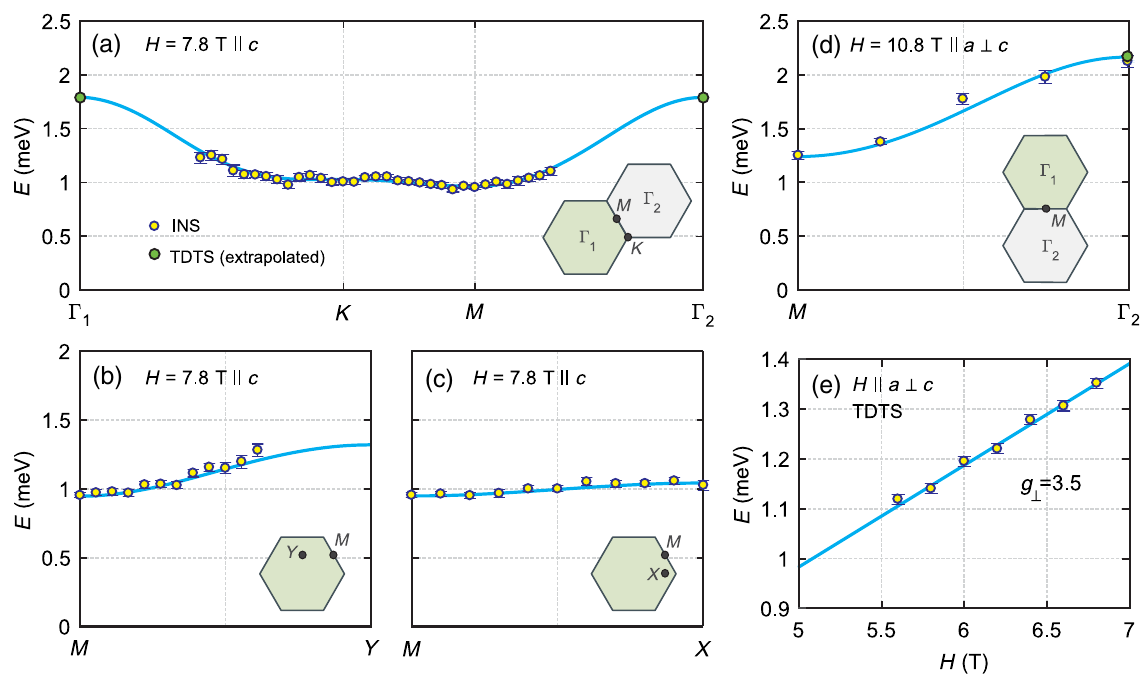
FIG. 3. (a) – (c) Energy dependence of spin-wave excitations in the field-saturated state from INS data along high-symmetry directions of the triangular Brillouin zone. The sample was cooled by a dilution refrigerator of base temperature T ¼ 0 . 06 K in a magnetic field k c ¼ 7 . 8 T. Solid blue lines show the results of the global fit using model C (see Table I). Green circles at the Γ points are the TDTS H dc data from Fig. 2(c) extrapolated to 7.8 T and included for display purposes. Error bars for these extrapolated data are smaller than the k a ¼ 10 . 8 T. Yellow circles show the position of the maximum intensity marker size. (d) INS data measured at T ¼ 0 . 32 K in a field H dc at each wave vector as determined from fits to the energy-dependent data. Green circle at the Γ 2 point shows the TDTS data extrapolated k a . Yellow circles represent to 10.8 T. (e) Energy versus field for spin-wave excitations at T ¼ 5 K in the TDTS Voigt geometry, i.e., H dc the resonant energy of the spin-wave peaks in the TDTS spectra (see SM [68]). Solid blue lines in (d) and (e) show the results of the global fit using model C (Table I). Note that the INS data in (a) – (c) are the same as published in Ref.